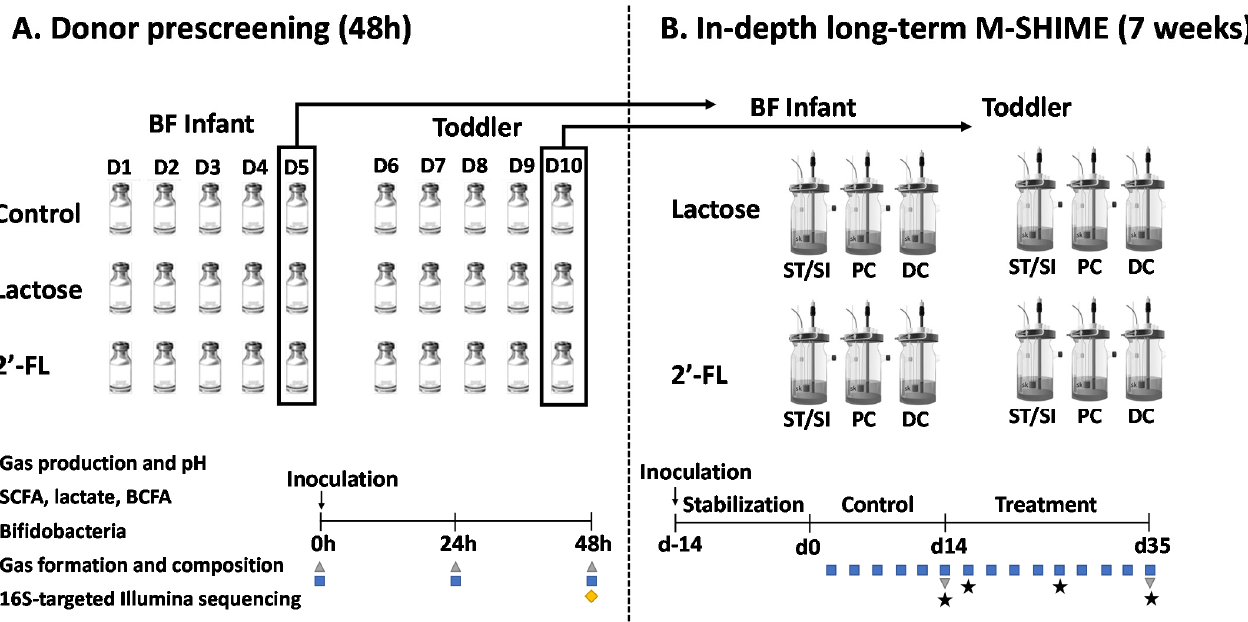
Figure 1. Schematic representation of the experimental set up: ( A ) Short-term incubations (part 1) to screen fecal samples from five BF infant and five toddler donors (48 h); ( B ) Long-term M-SHIME ® study (part 2) using the selected fecal samples from the screening of a single BF infant and toddler donor, respectively (7 weeks). 2’-FL = 2’fucosyllactose; BF = breastfed; SFCA = short-chain fatty acid; BCFA = branched-chain fatty acid; ST/SI = stomach/small intestine; PC = proximal colon; DC = distal colon; M-SHIME ® = mucosal simulator of the human intestinal microbial ecosystem.